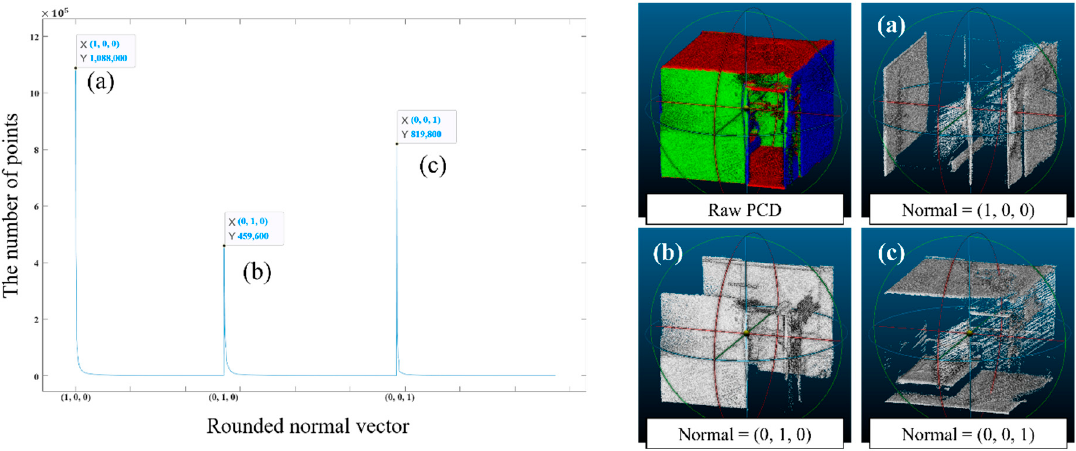
Figure 7. Segmentation based on the normal vectors. ( a ) PCD whose normal vector of x is one; ( b ) PCD whose normal vector of y is one; ( c ) PCD whose normal vector of z is one.